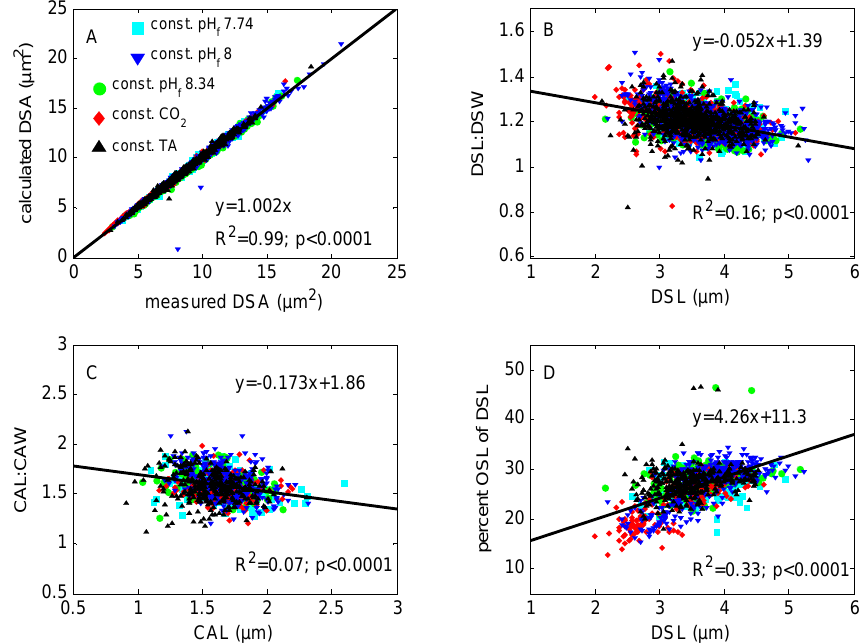
Fig. 3. Morphology of coccoliths. Each data point represents an individual coccolith. (A) Correlation between measured DSA and DSA calculated from DSL and DSW using Eq. (4). (B) Aspect ratio of distal shield with increasing DSL. (C) Aspect ratio of central area with increasing CAL. (D) Percentage of OSL that contributes to the total DSL. Symbol size and colour coding is shown in panel (A) . 1 Malformation =